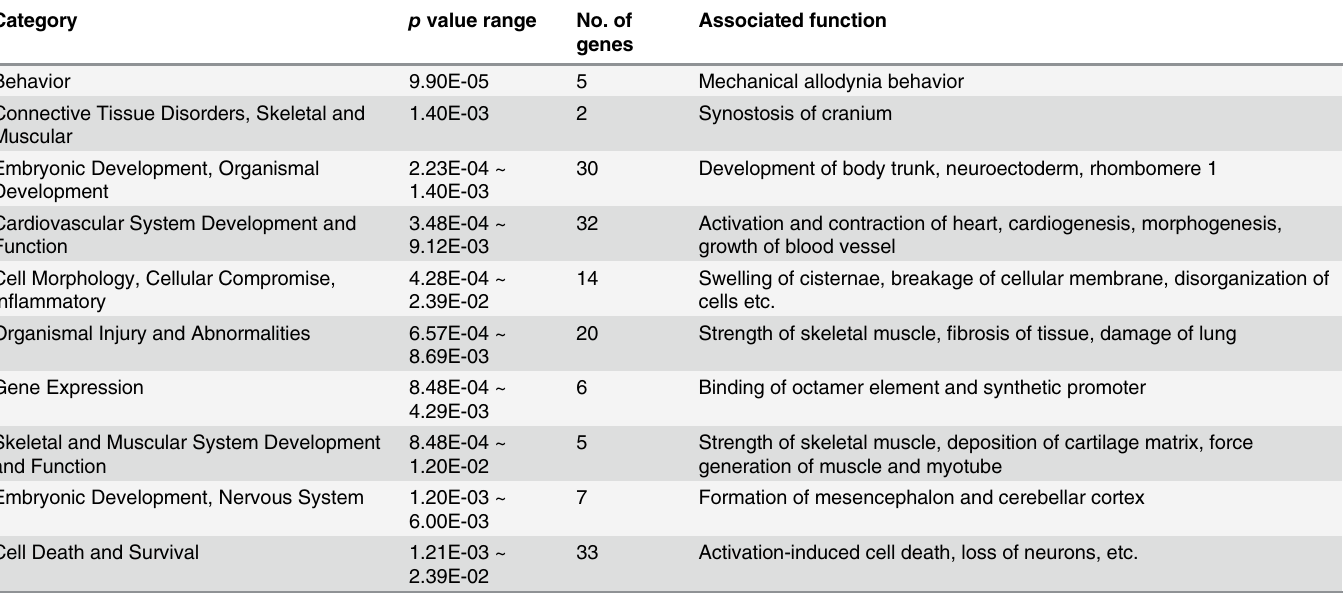
(Table 6). Functional analyses of DEGs in both AFS and amniocytes showed that particular Table 5. Top biological functions identified in unique genes of AFS by Ingenuity Pathway Analysis (IPA). Category